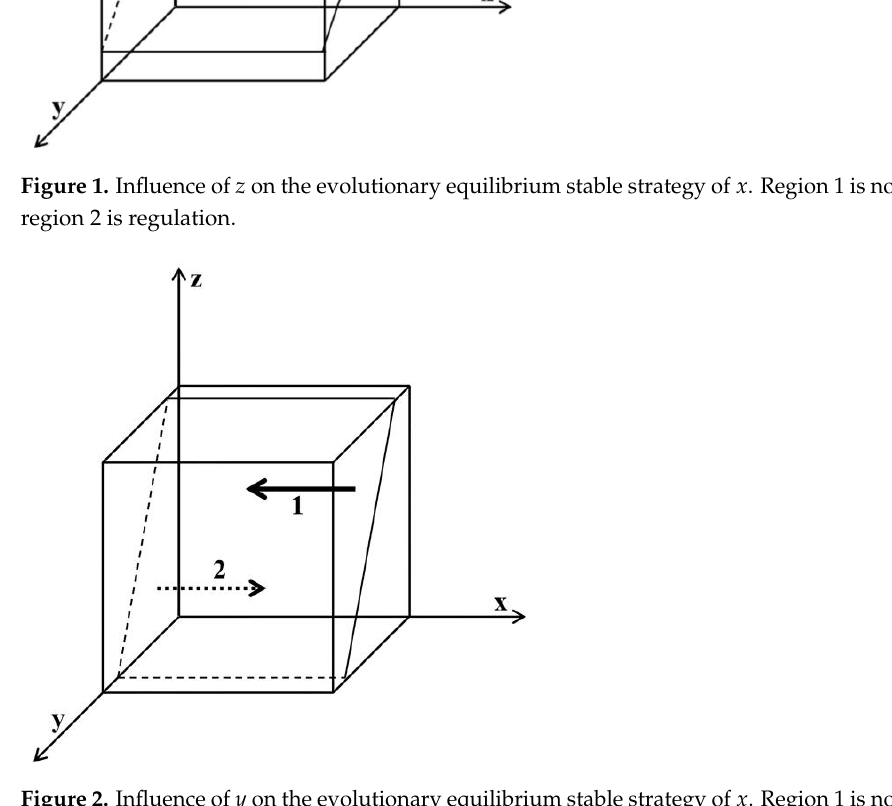
Figure 3. Influence of x on the evolutionary equilibrium stable strategy of y . Region 1 is no increase in production; region 2 is increase in production.